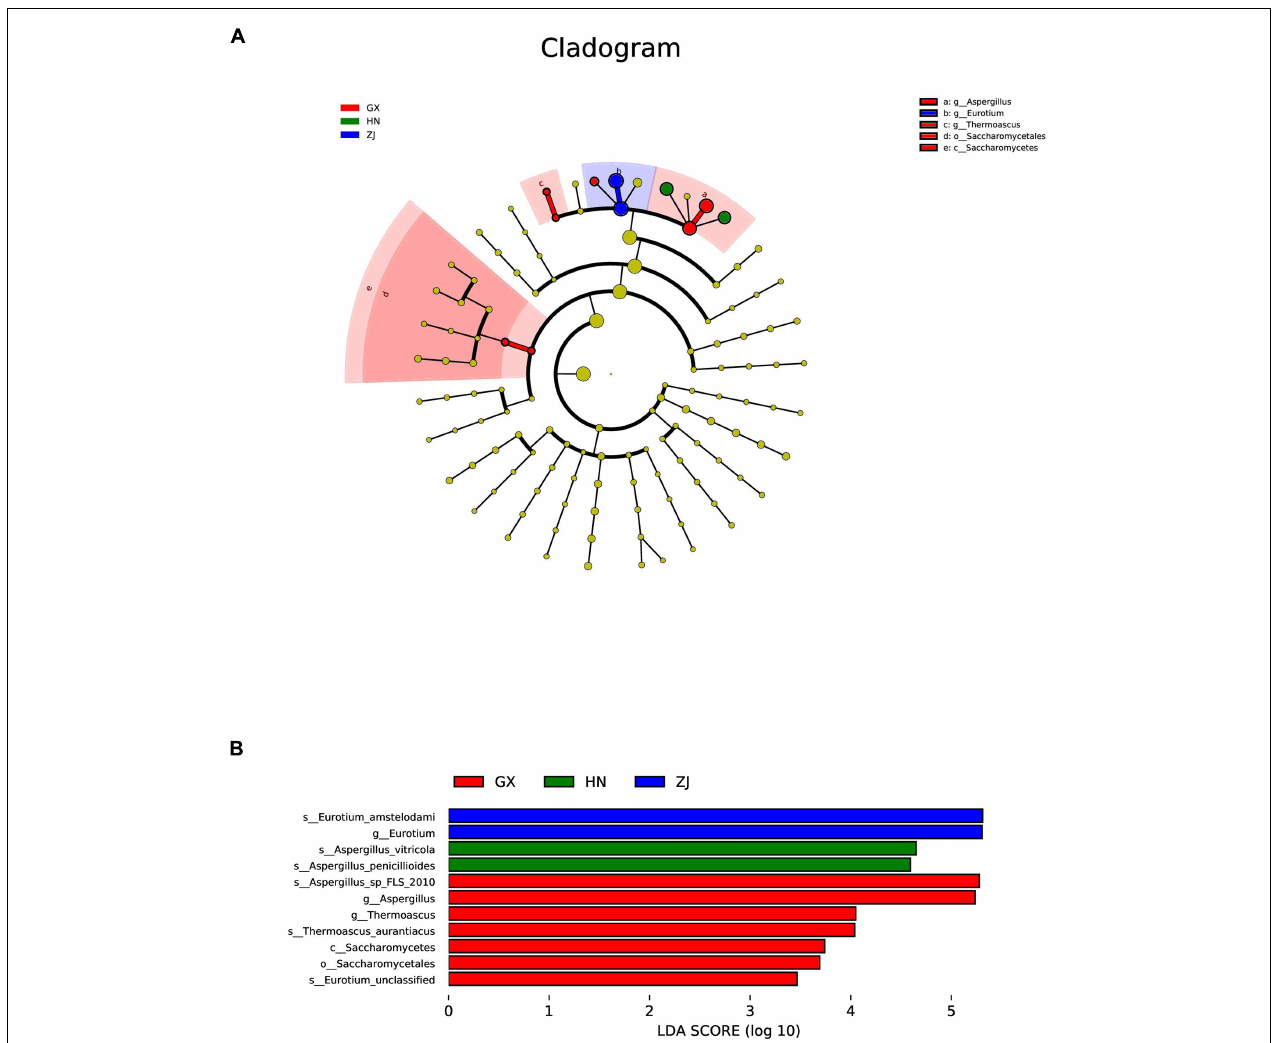
FIGURE 4 | Cladogram (A) and linear discriminant analysis (LDA) score (B) showed the significant abundance differences of fungal taxa by LEfSe analysis. The node size represents the difference in relative